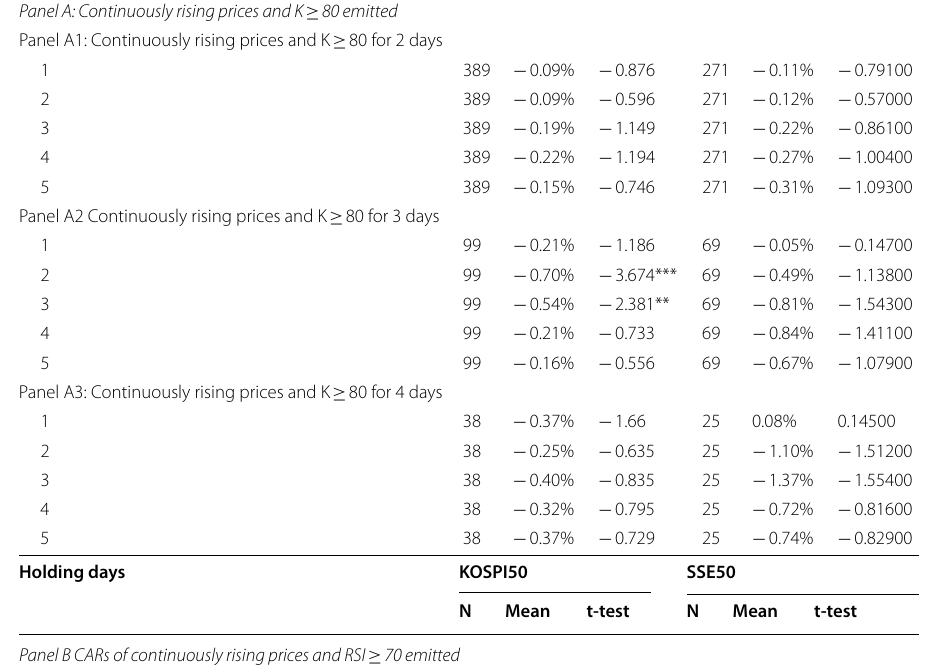
Panel B CARs of continuously rising prices and RSI Panel B1: Continuously rising prices and RSI 2